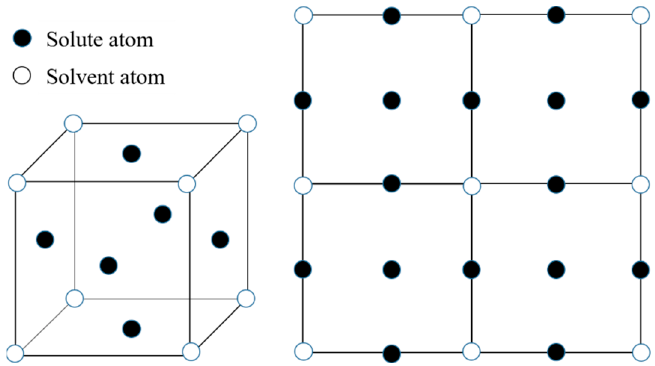
Figure 3. The γ ’ -phase structure and its projections.